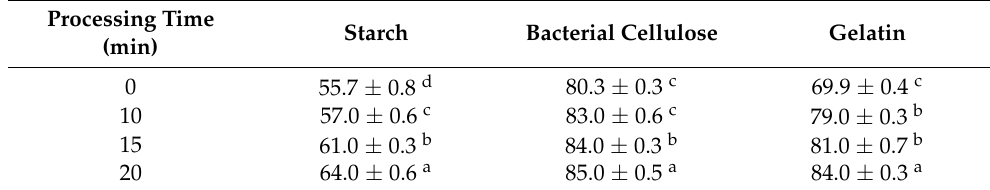
Table 3. The contact angle of the starch, bacterial cellulose, and gelatin films treated with dielectric barrier discharge plasma at an optimal excitation frequency (50 Hz for the starch film and 900 Hz for the bacterial cellulose and gelatin films) without Mylar™ support. For each property, values followed by at least one common letter are not different from each other ( p > 0.05).